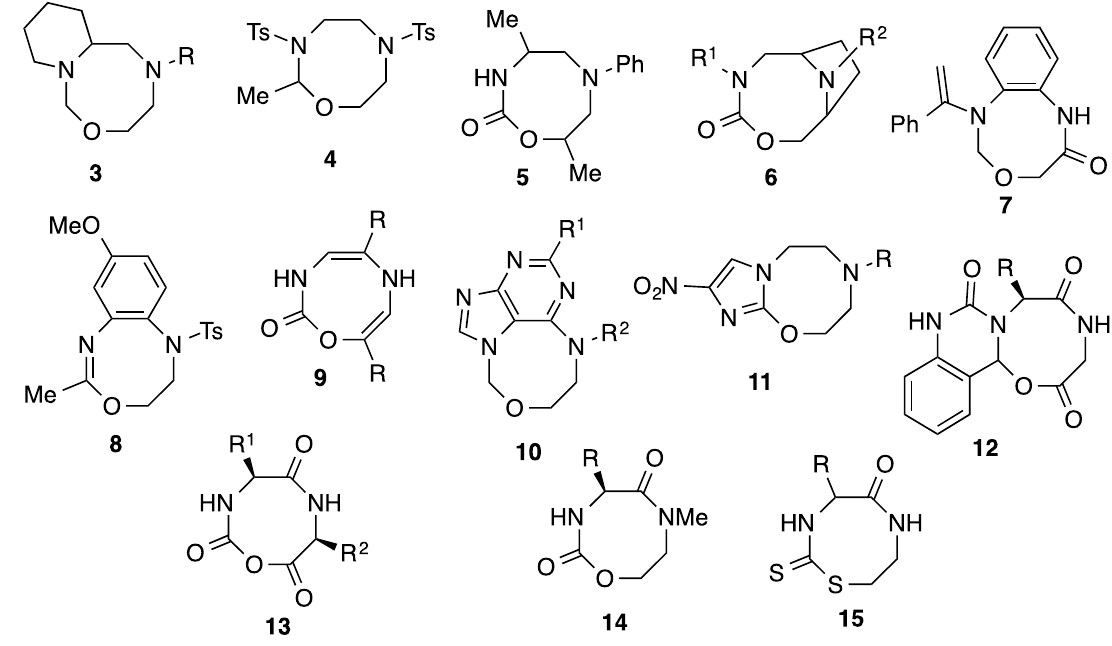
Figure 2. Related 1,3,6-oxadiazocine ring systems.